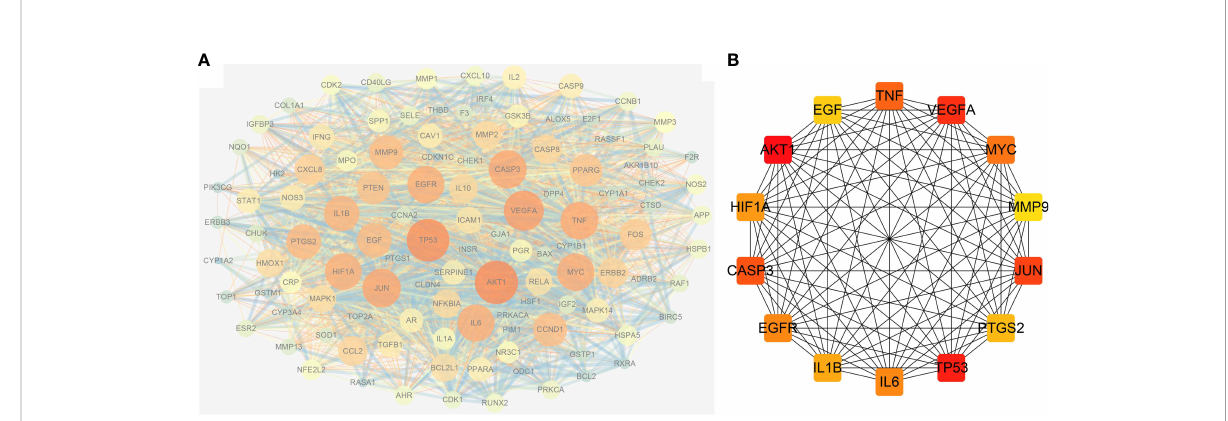
FIGURE 3 Reconstruction of the PPI network. (A) Construction of the PPI network using Cytoscape and analysis of the network using Network Analyzer. (B) Clusters retrieved from (A) ; the color depth of nodes is proportional to the degree of